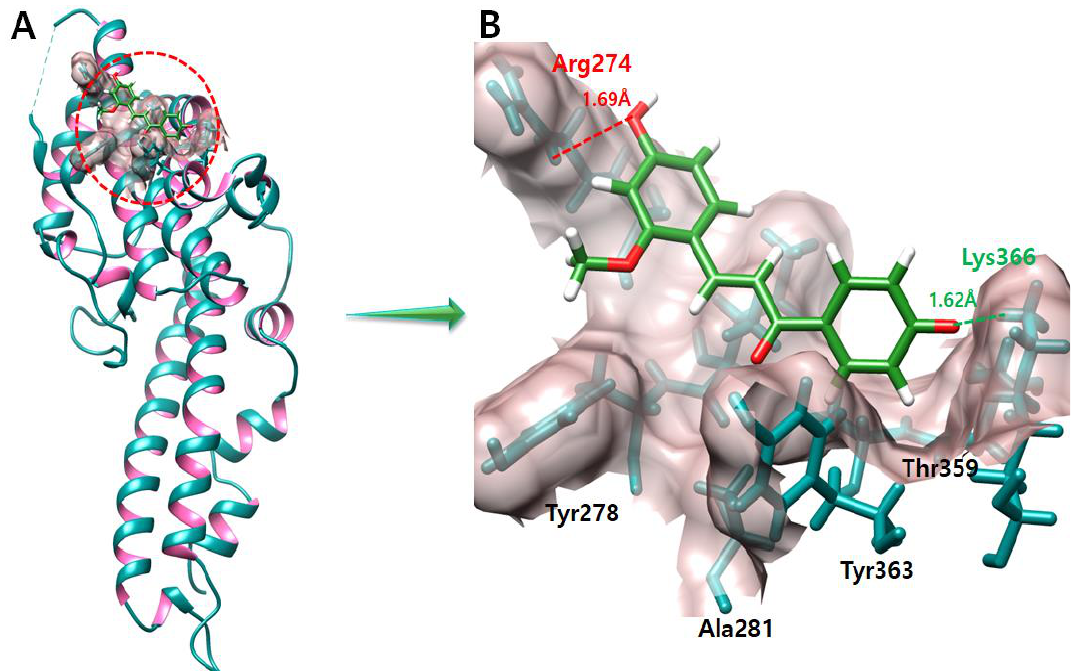
Figure 6. The figure ( A ) shows the echinatin and DBP complex. In Figure ( B ) salt bridges and hydrogen bonds produced during the docking experiment are depicted in green and red color, respectively. One oxygen atom of echinatin forms a salt bridge with Lys366 with a length of 1.62 Å . On the other hand, another oxygen atom of echinatin forms a hydrogen bond with Arg274 with a length of 1.69 Å .